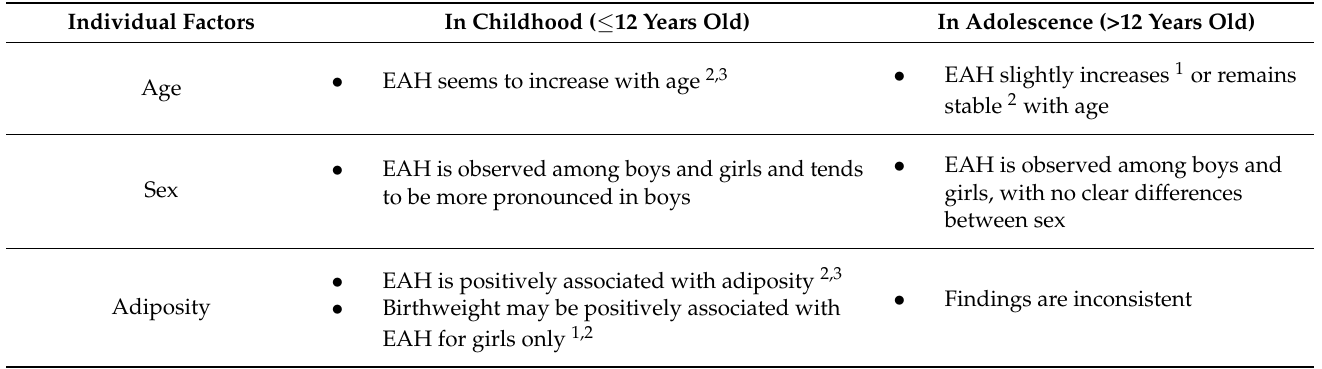
Figure 1. A PRISMA flow diagram of the screening process. Table 1. The overall conclusions for individual factors associated with eating in the absence of hunger (EAH) in children and